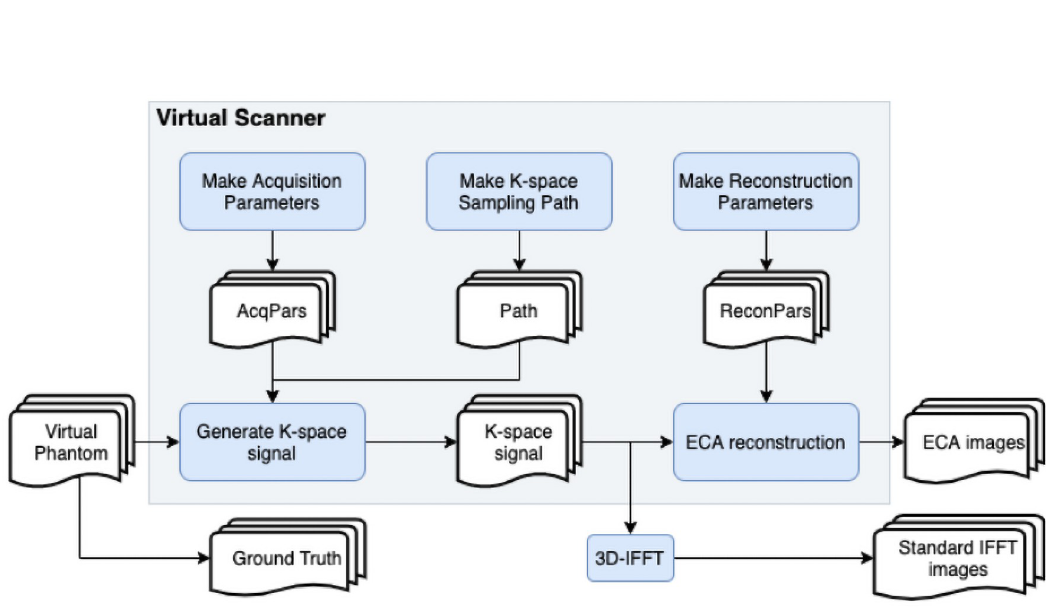
Fig 4. A flowchart summarizing the virtual scanner pipeline.